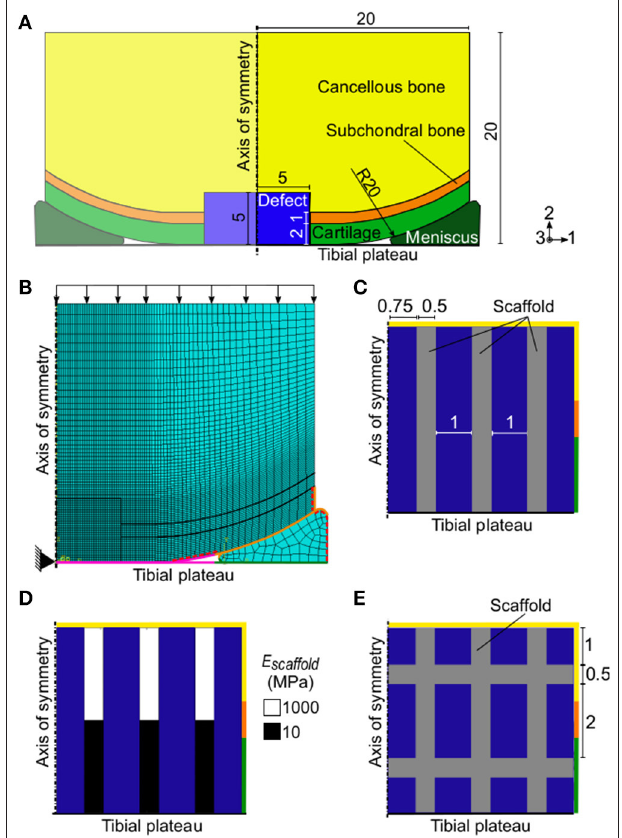
FIGURE 2 | Axisymmetric FE model of a femoral condyle featuring an osteochondral defect. (A) FE model with empty osteochondral defect. Axes 1, 2, and 3 refer to the radial, axial, and circumferential directions, respectively; (B) mesh and settings of FE model. Black arrows indicate the applied pressure load. The black triangle indicates the encastre boundary condition. Magenta, orange, and green surfaces highlight the femoral condyle-tibia, cartilage-meniscus, and meniscus-tibia interactions, respectively. The red dashed lines mark the free cartilage surfaces with pore pressure of 0 MPa during the consolidation step; (C) and (E) detail of defect region with vertical struts and grid-like scaffold, respectively. The rest of the model was identical to the one with empty osteochondral defect. All reported values are in mm; (D) biphasic scaffold with 10–1,000 MPa elastic modulus (E scaffold ) implemented in the defect. The colors of the borders indicate the neighboring tissues in the FE model of the femoral condyle: yellow, orange, and green stand for cancellous bone, subchondral bone, and cartilage, respectively. The blue areas represent the granulation tissue at day 1.